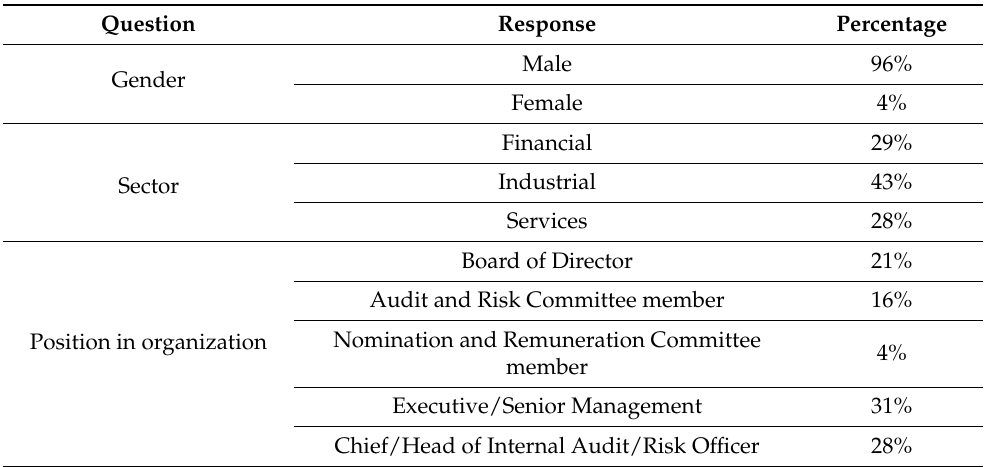
Table 4. Demographic Profile of Respondents.